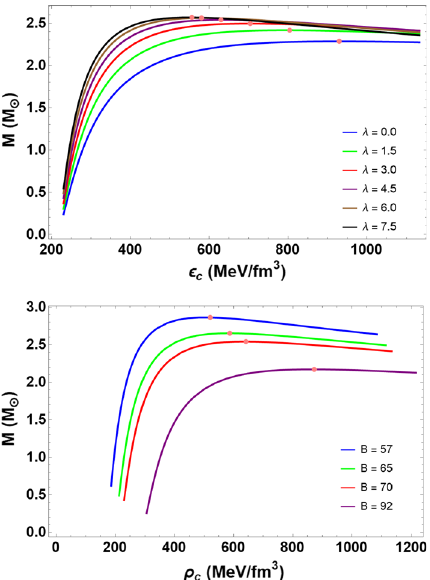
Fig. 3 M − ρ c relationship is presented for the selected EoS together with the same set of parameters in Figs. 1 and 2,